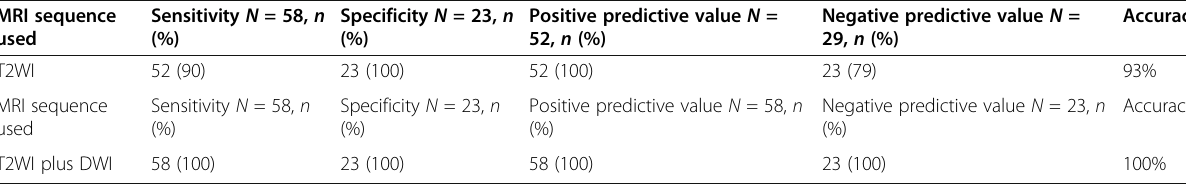
Table 5 HR T2WI vs. HR T2WI plus DWI differentiate tumors confined to urinary bladder from tumors with extravesical extension